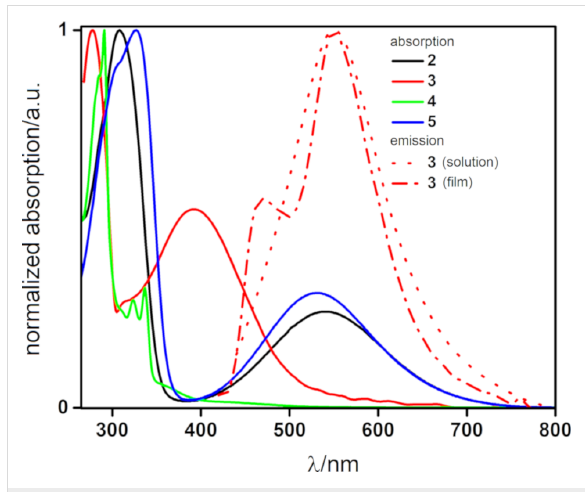
Figure 5: UV–vis absorption spectra of 2–5 in DCM and photolumines- cence spectrum of 3 in degassed DCM and in 10 wt %-doped films in a PMMA matrix ( λ exc = 400